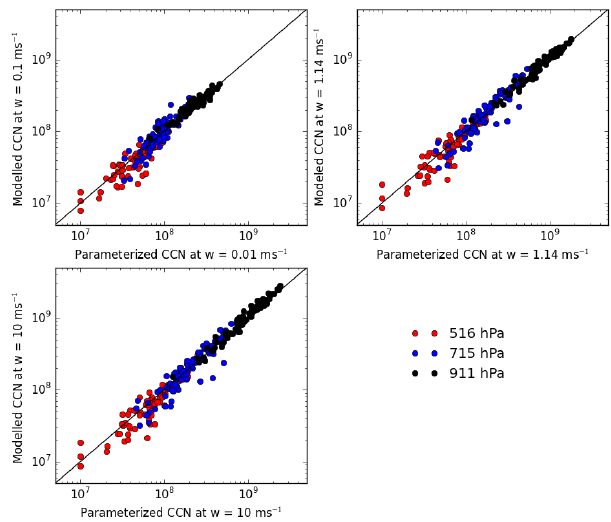
Figure 9. Scatter diagrams of modelled CCN number concentra- tions against parameterized CCN number concentrations, for w = 0 . 01 (upper left), 1.14 (upper right), and 10ms − 1 (lower left), and for 516 (red), 715 (blue), and 911hPa